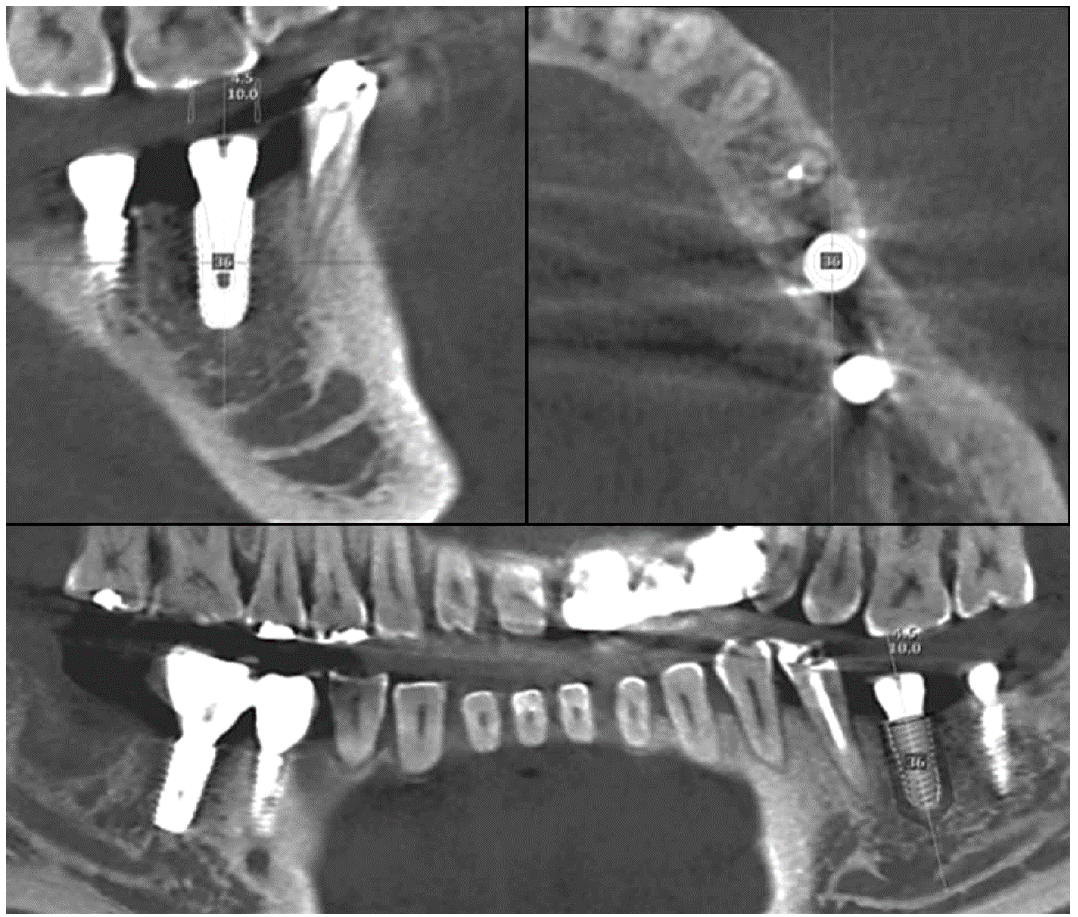
Figure 2. A library image of implant fixture is loaded on the post-operative CT. By this image replacing analysis, the implant placed position is determined.